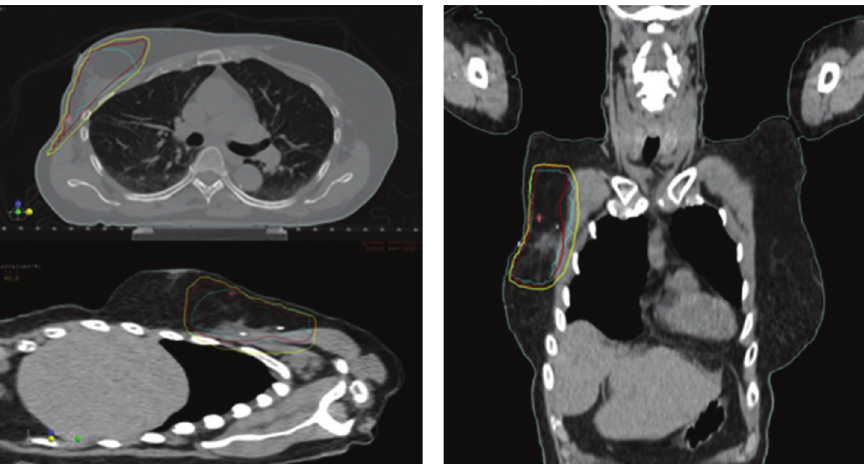
Figure 1: Partial breast radiation therapy plan utilizing external beam radiation therapy with photons. Blue: planning target volume- evaluation (PTVeval), red: 95% isodose line, yellow: 90% isodose